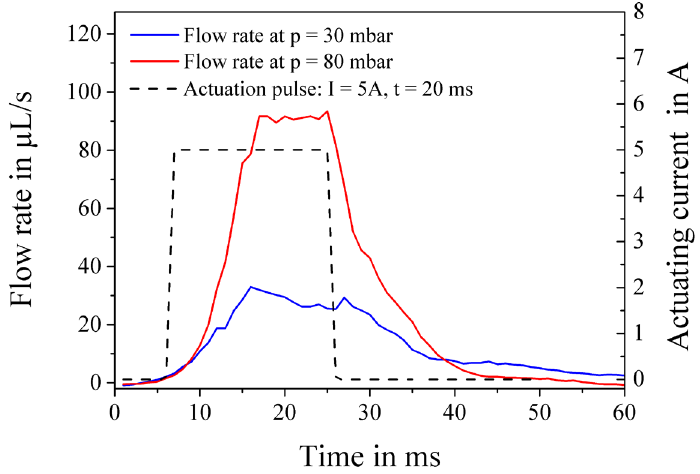
Figure 8. Flow profile during the dispensing for an applied actuating pressure of 30 and 80 mbar, respectively. The actuation time was set to 20 ms and the actuation current to 5